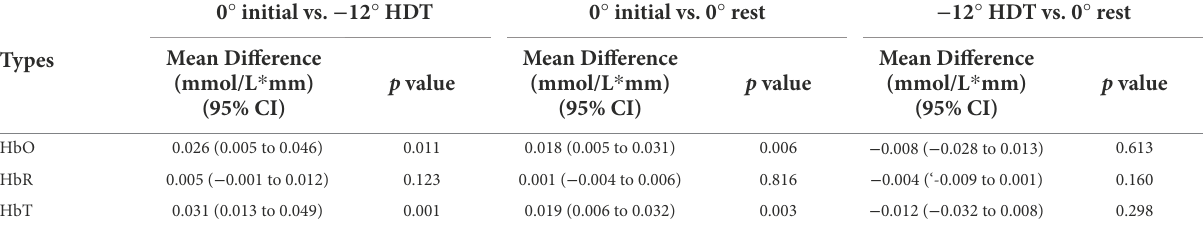
TABLE 2 Results after pairwise comparison of hemodynamic indexes and positions.